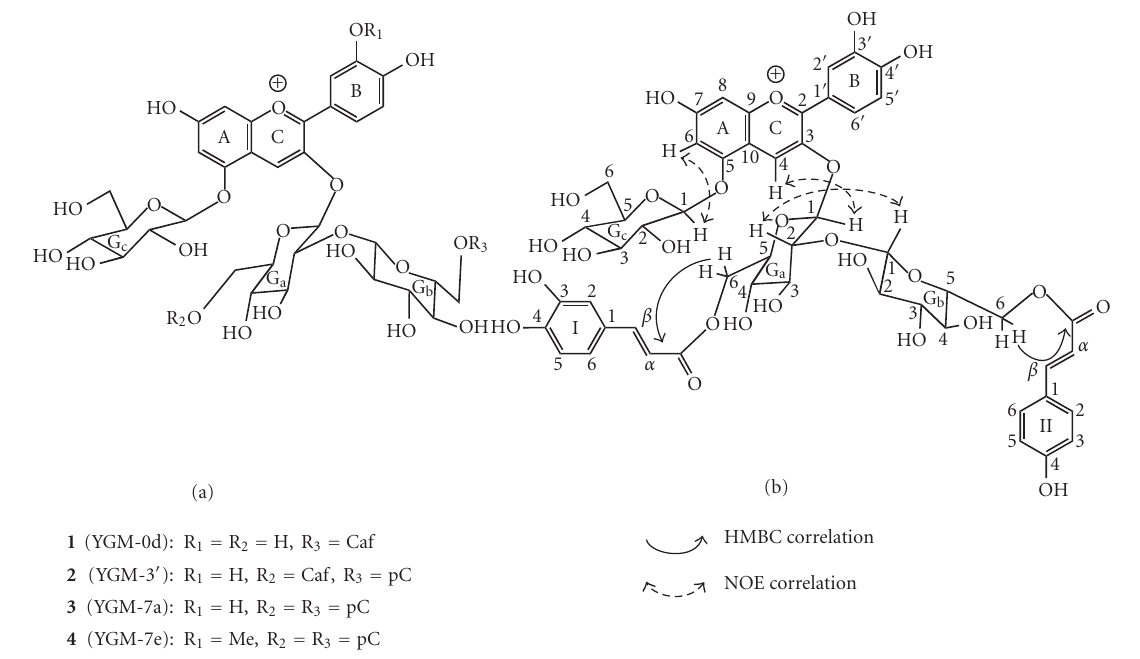
Figure 2. Purple sweet potato callus anthocyanins. (a) Structures of 1 , 2 , 3 , and 4 ; Caf = ca ff eic acid and pC = p -coumaric acid, (b) typical NOE and HMBC correlations of ca ff eoyl- p -coumaroylated anthocyanin 2 .